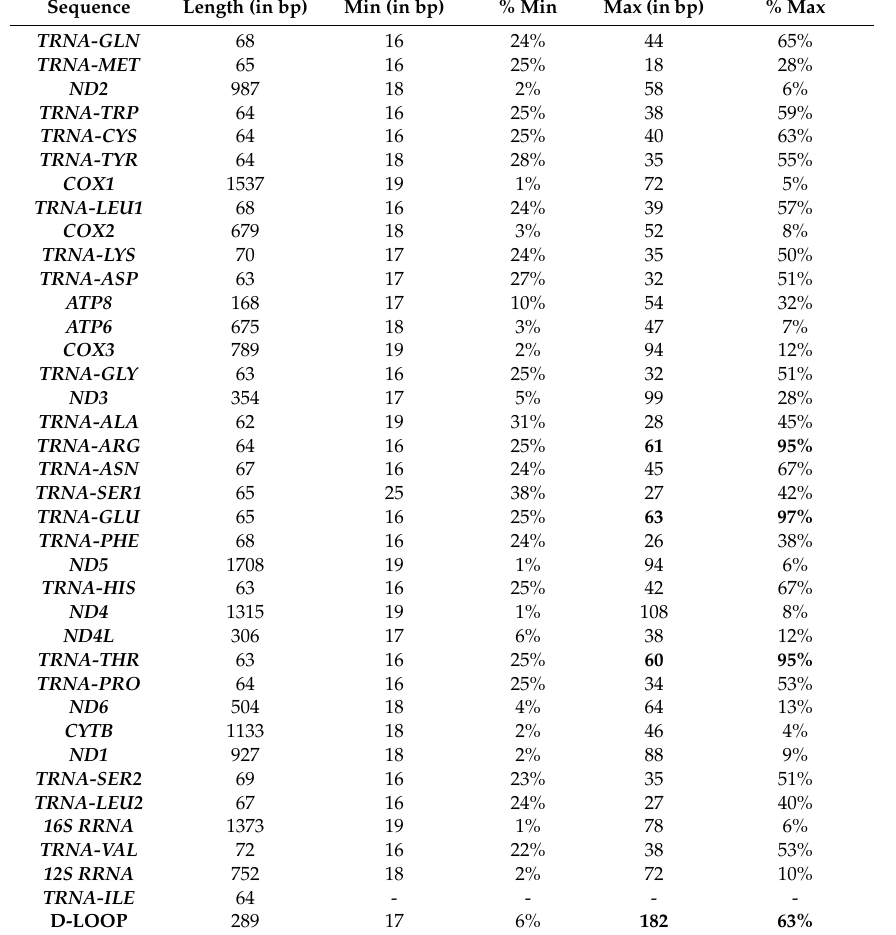
Table 3. Minimal and maximal length of each mtDNA gene fragments located in the nuclear genome. Sequence